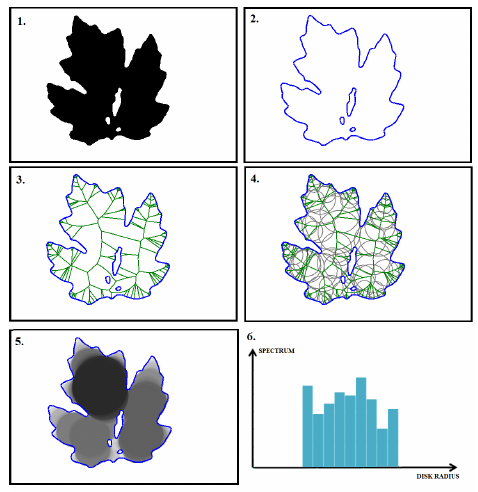
Figure 3: Discrete-continuous morphological pattern spectrum algorithm for disc SE. Steps from 1 to 6 shown. 1. 2D Shape; 2. Polygon; 3. Continuous skeleton; 4. Continuous skeleton and skeleton radial function; 5. Thickness map (as gray scale